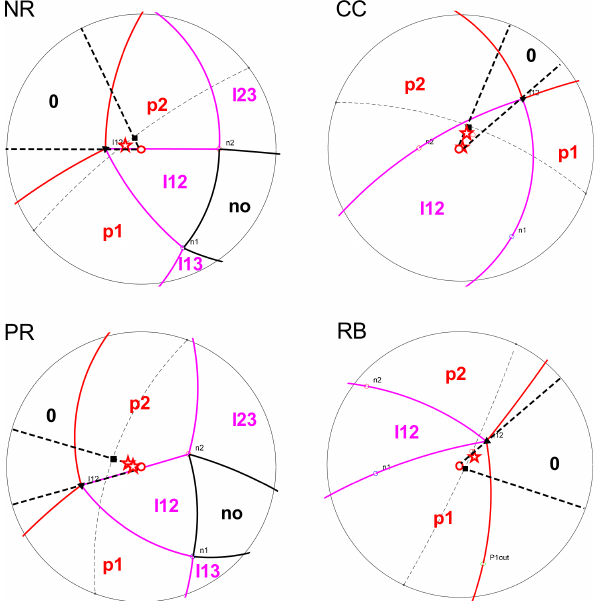
Figure 7. Stereographic conform projections (lower hemisphere projected from upper focal point) of the trihedral/dihedral regions (solid lines) that define different sliding mechanisms depending on the direction of the resultant force. I ij , sliding along the intersec- tion line between the planes i and j and pi , sliding along the plane i . Light dashed lines are the projections of the average local slope face. Red stars indicate the resultant orientations corresponding to the minimum F s during the seismic shocks (see Fig. 8). Full tri- angles and squares indicate the orientation of the intersection line ( I 12 ) between the two planes and the dip direction of the slope face,